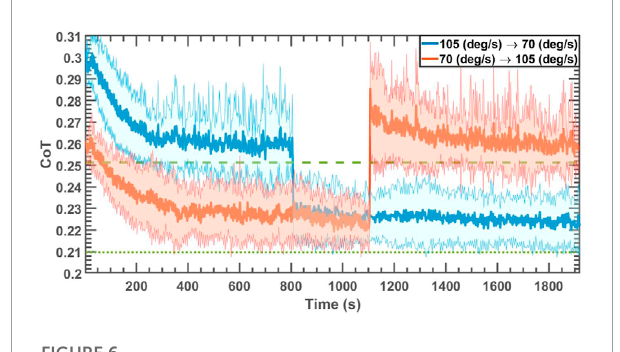
Frontiers in Robotics and AI